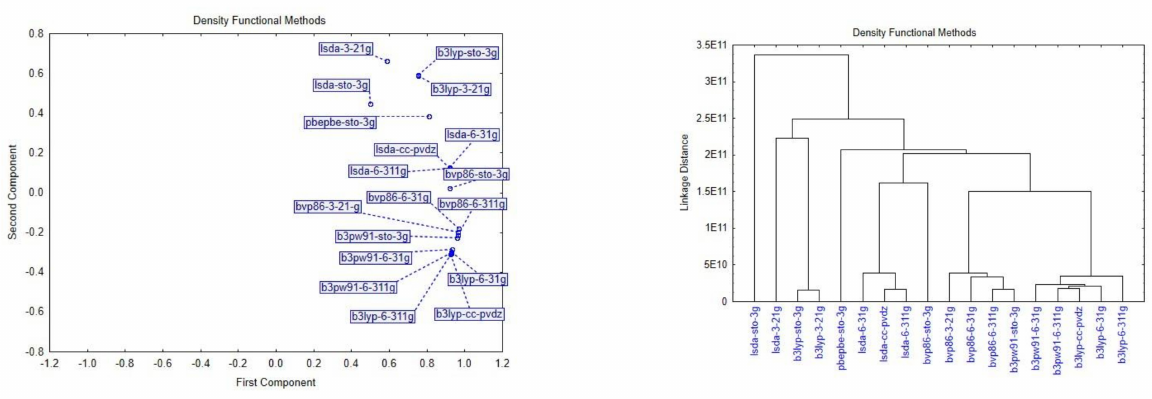
Figure 7. Score plot showing the distribution of the methods in the principal components p1 and p2 and cluster analysis.